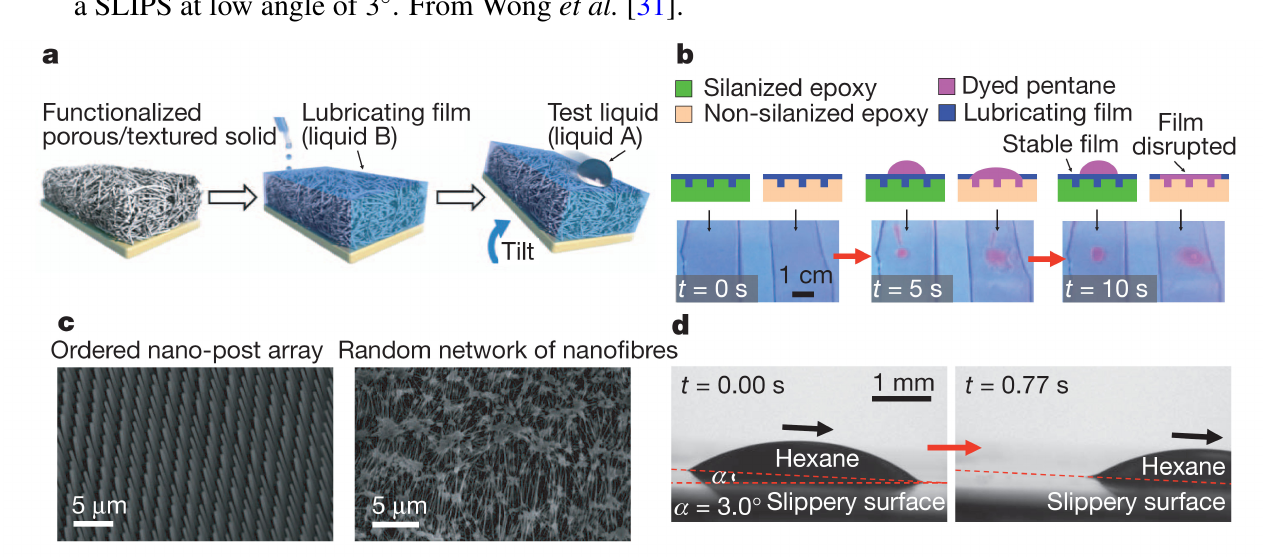
Figure 20. Design of SLIPS. ( a ) Schematics showing fabrication of SLIPS by infiltrating functionalized porous/textured solid with a low-surface energy, chemically inert liquid to form a physically smooth and chemically homogeneous lubricating film. ( b ) Comparison of stability and displacement of lubricating films on silanized and non-silanized textured epoxy substrates. Top panels show schematic side views; bottom panels show time-lapse optical images of top views. Dyed pentane was used to enhance visibility. ( c ) Scanning electron micrographs showing the morphologies of porous/textured substrate materials: an epoxy-resin-based nanofabricated post array (left) and a Teflon-based porous nanofibre network (right). ( d ) Optical micrographs demonstrating mobility of